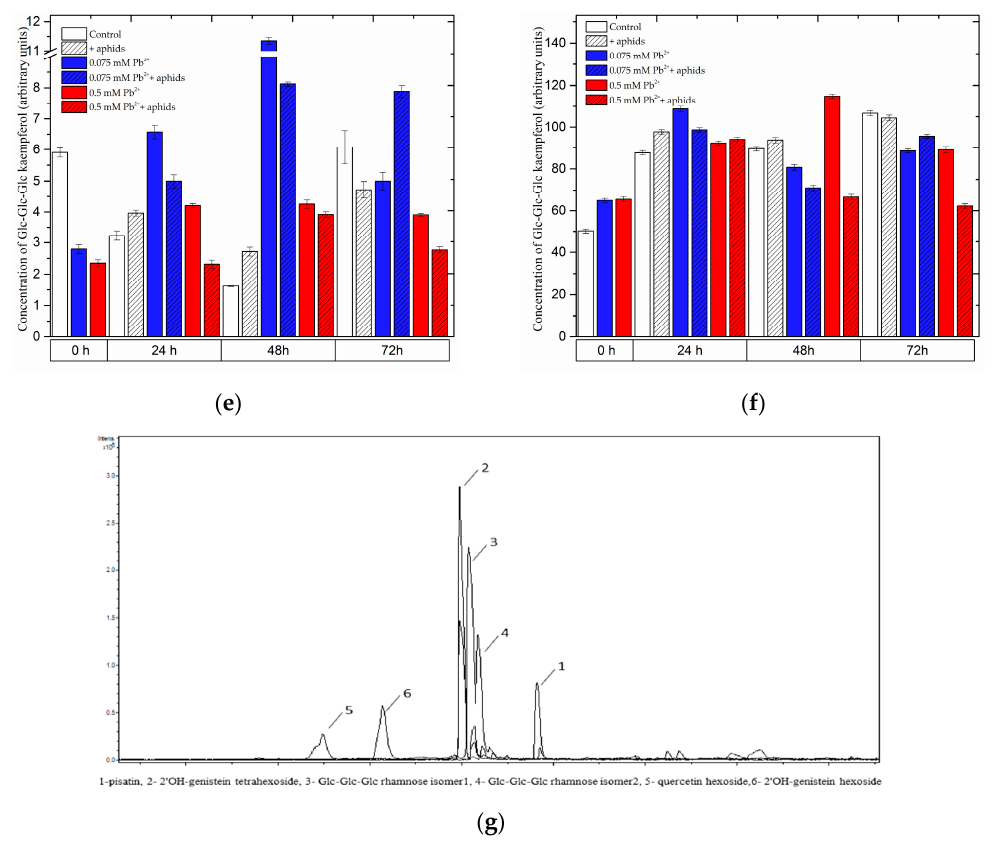
Figure 4. The effect of lead and A. pisum on the level of isoflavonoid and flavonoid glycosides 2’OH genistein hexoside ( a , b ), Glc-Glc-Glc rhamnose ( c , d ), Glc-Glc-Glc kaempferol ( e , f ), in roots ( a , c , e ) and leaves ( b , d , f ) of pea seedlings. An LC-MS extracted ion chromatogram showing profiles of phenolic componds found in leaves ( g ). Arbitrary unit means a relative unit of measurement to show the amount of substance (intensity), the reference measurement is dependent on individual measurement on MS (ion counts on MS detector). The data were obtained in three independent experiments and statistically analysed using ANOVA ( p -values at α = 0.05). Hypotheses on the equality of means were verified by the two-sample t -test. To account for multiple testing, we used the Bonferroni correction (statistically significant differences are shown in Table S1).